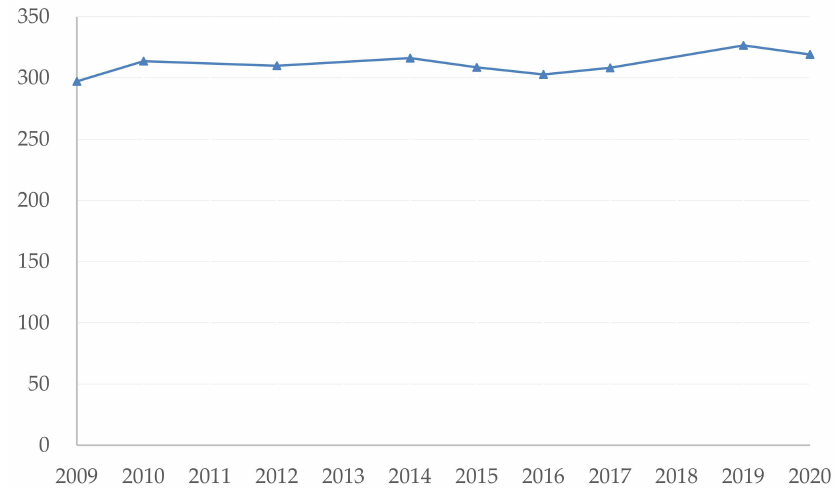
Figure 10. The change of land-use intensity